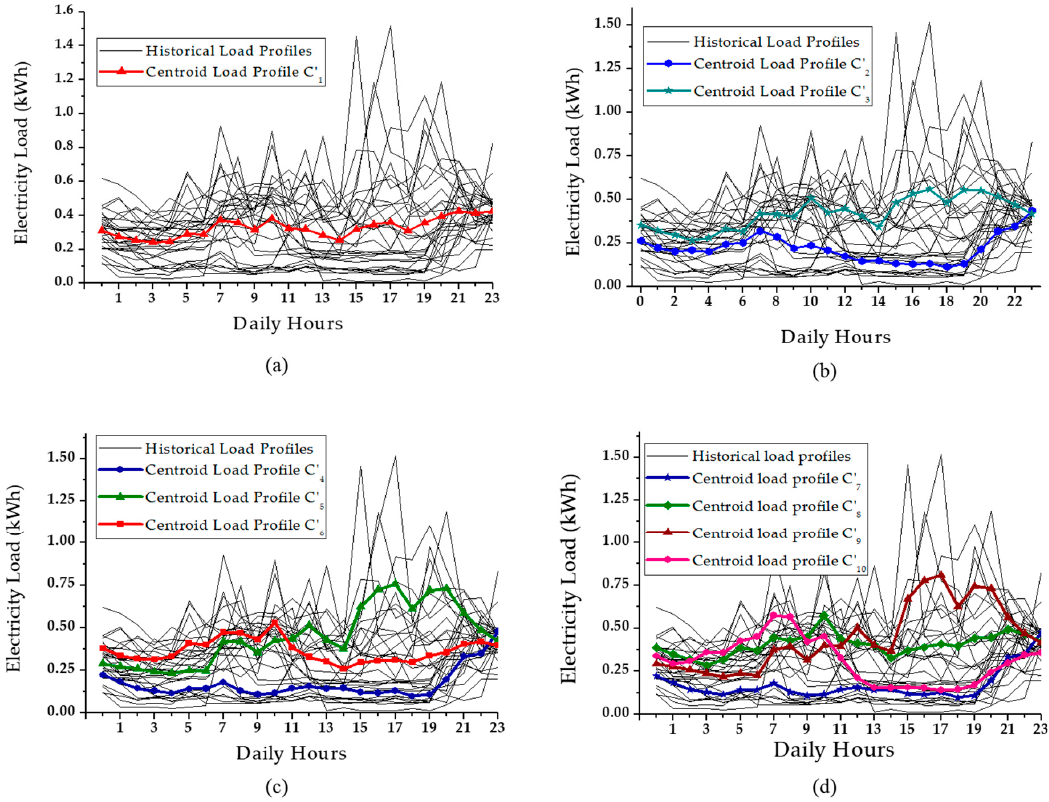
Figure 5. Centroid load profiles generated using multiple k-means clustering algorithm with different clustering number k : ( a ) k = 1; ( b ) k = 2; ( c ) k = 3, and ( d ) k =